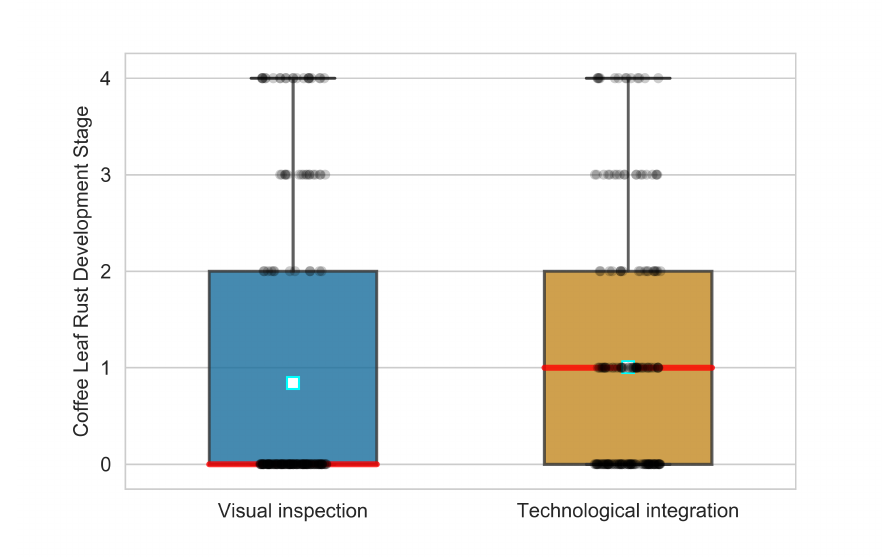
Figure 13. Data distribution of the observations for both